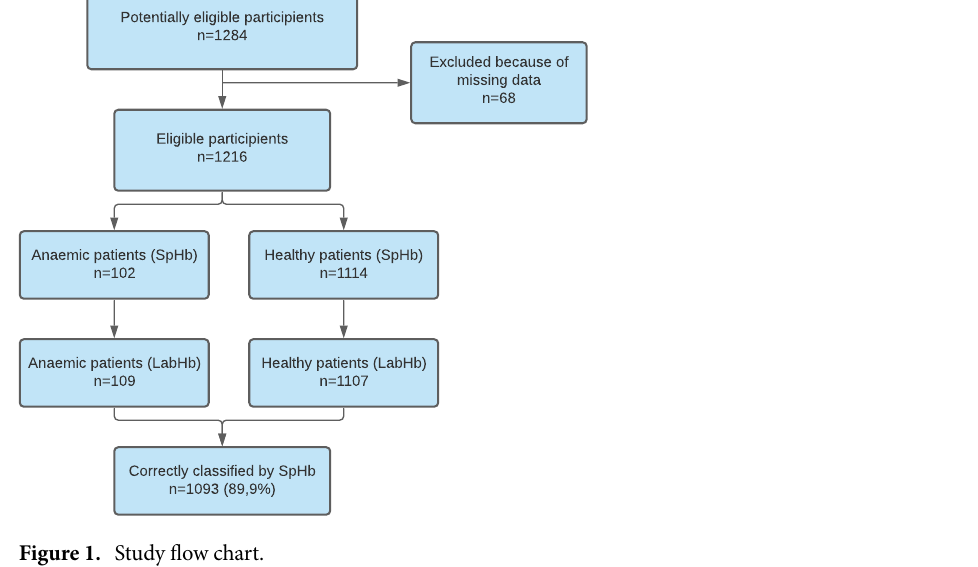
Figure 1. Study flow